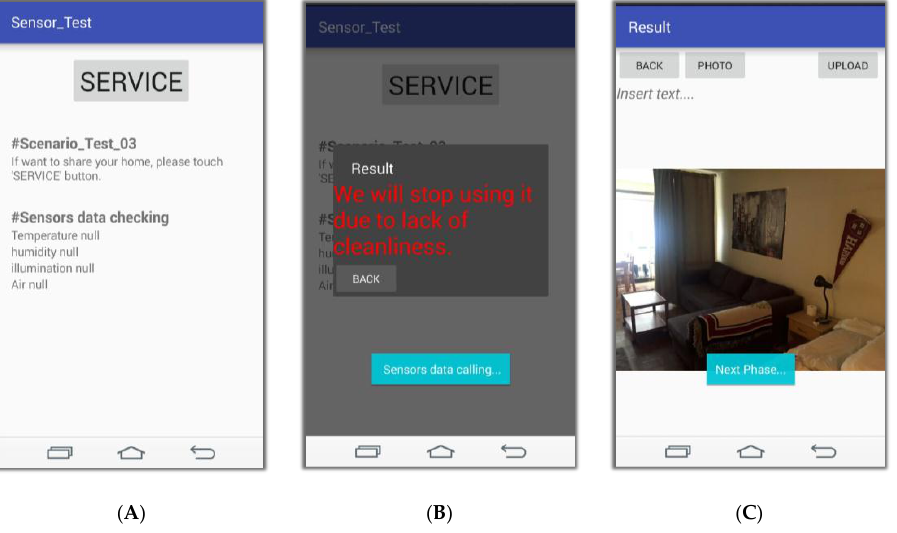
Figure 16. Screen for the service application: ( A ) Application access and Confirm sensing value; ( B ) Non-conformity after service execution; ( C ) Enter information about the share target.